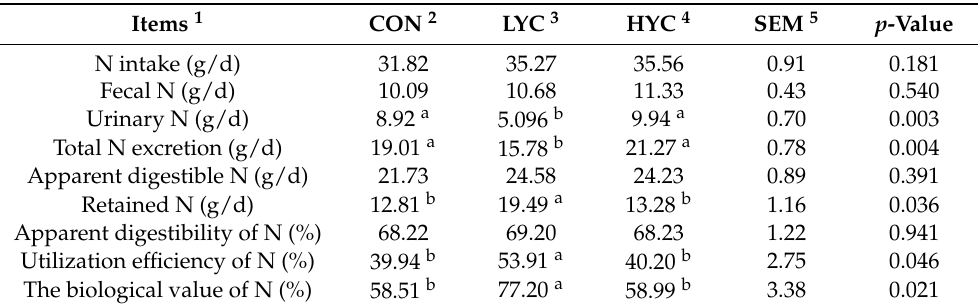
Table 4. Effect of dietary different supplemental levels of YC on the nitrogen metabolism of fattening Hu